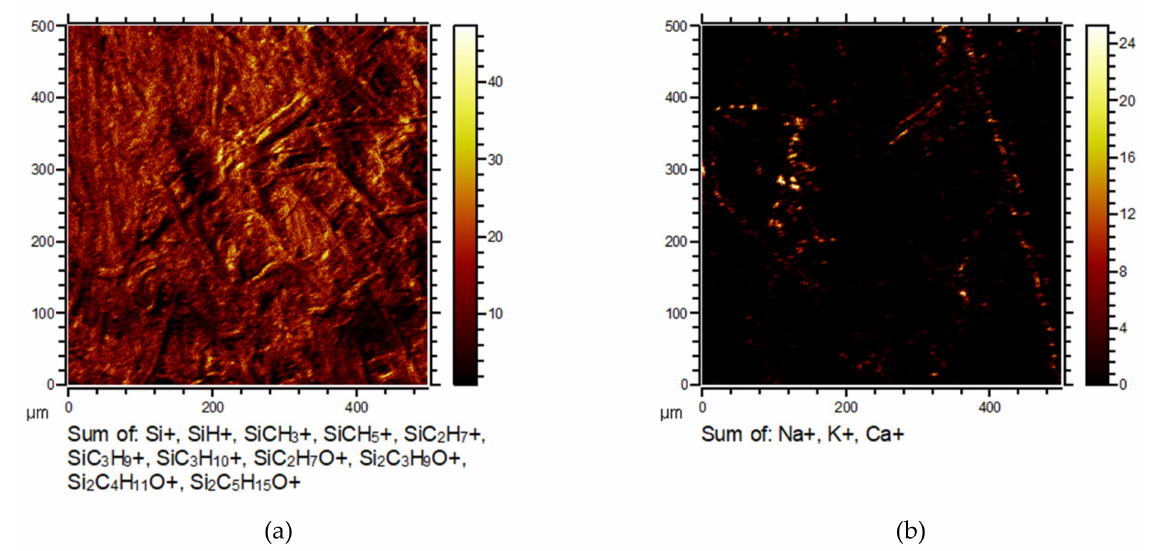
Figure 12. Micrographs of positive secondary ions emitted from paper 1 covered with HMDSO like layer by industrial plasma reactor. On the micrograph ( a ) are ions representing the HMDSO layer and on the micrograph ( b ), Na, K, and Ca